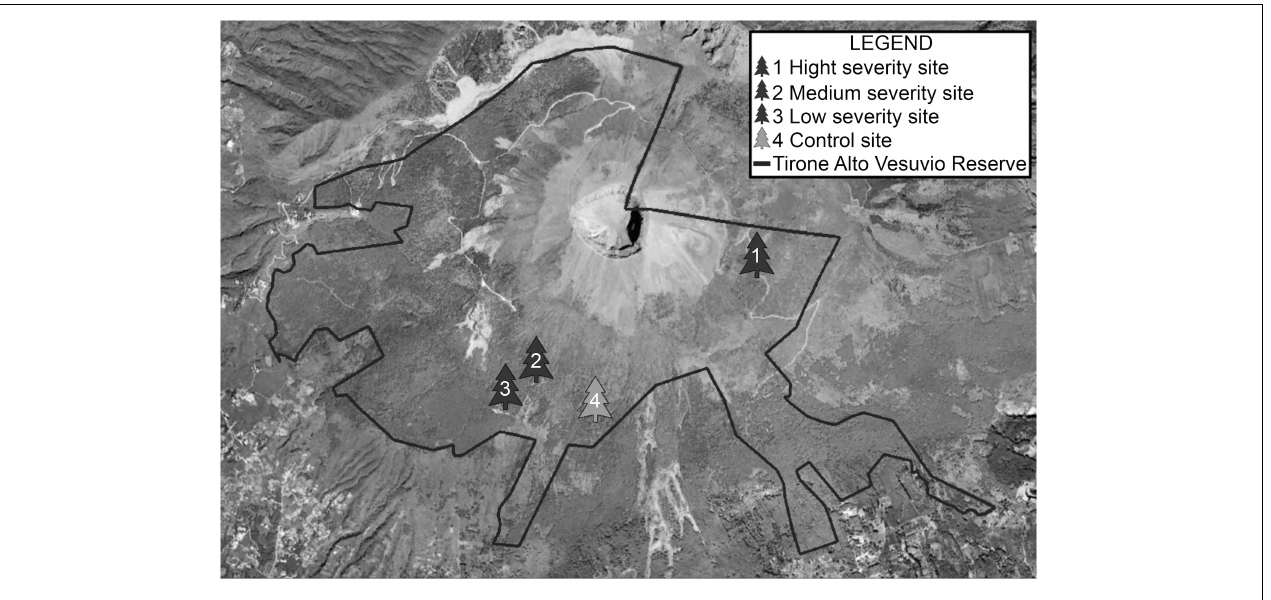
FIGURE 1 | Sampling sites in the Tirone Alto Vesuvio Nature Reserve of the Vesuvio National Park (Italy).